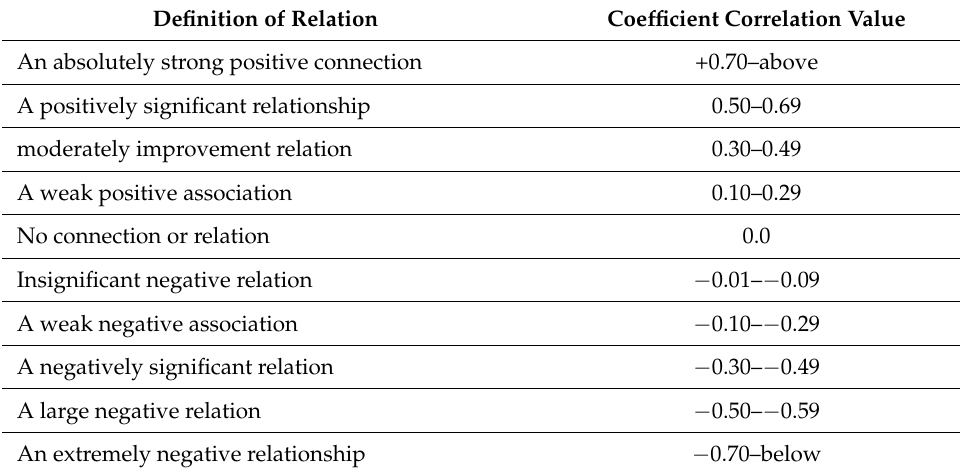
Table 3. The correlation value for the ‘r’